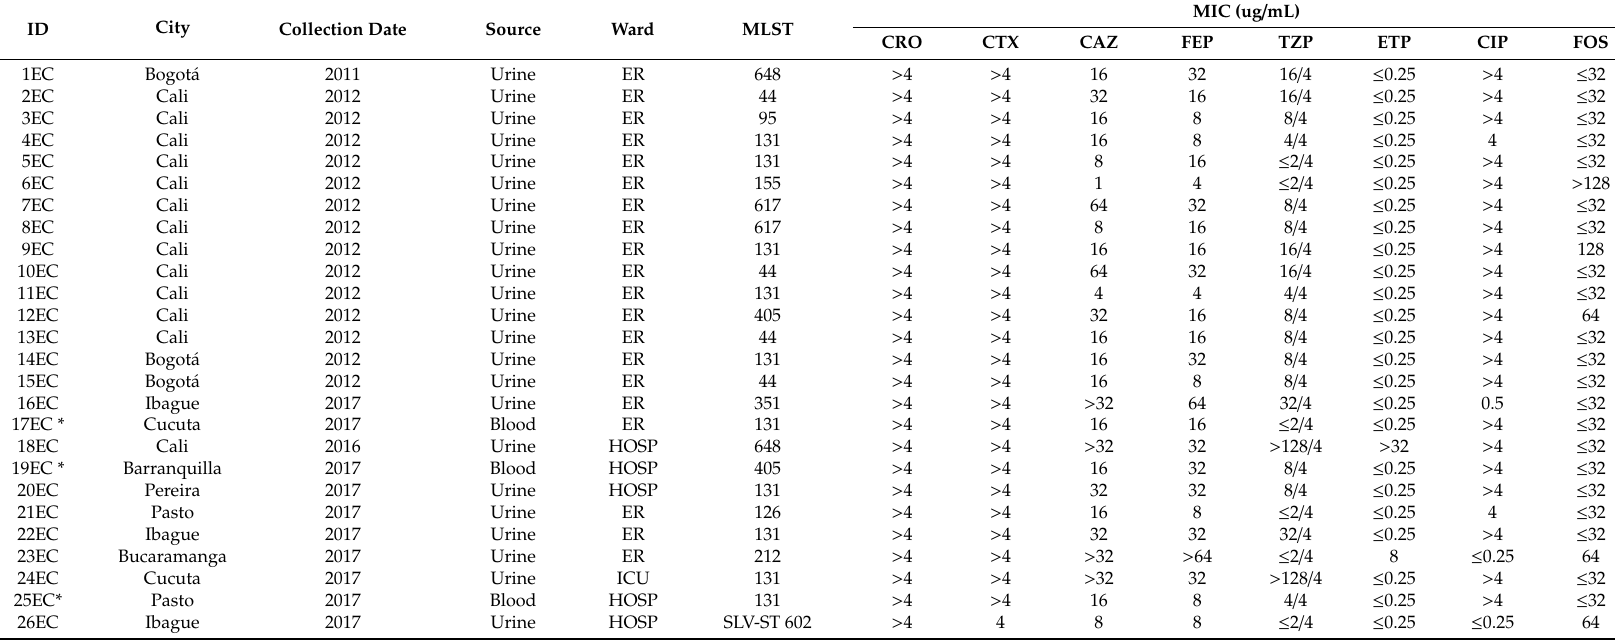
Table 1. Demographic and microbiological data of CTX-M-harboring Escherichia coli